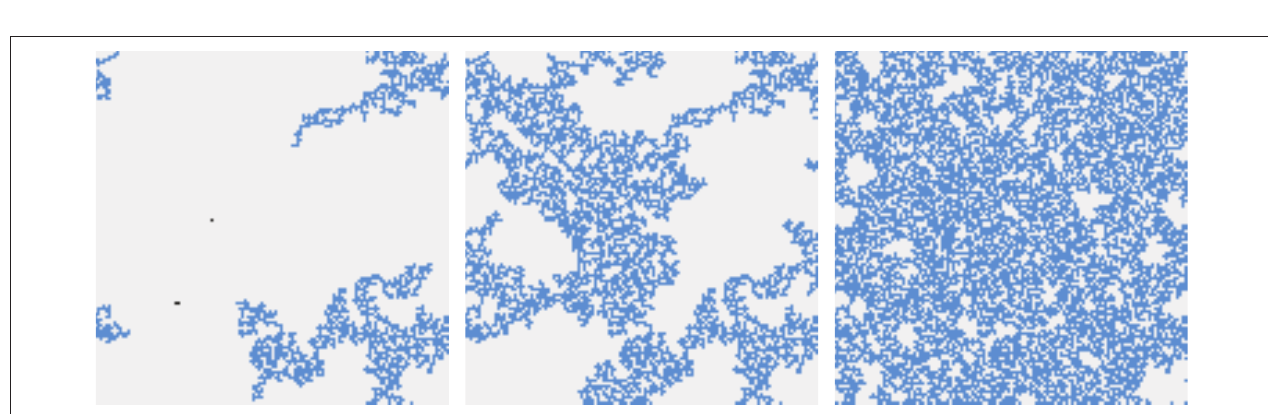
FIGURE 5 | Hole structure of a square lattice ( N = 128 2 ) LLS fiber bundle with the Weibull threshold distribution P ( x ) = 1 − exp ( − x + 1 ) at three different damages: k / N = 0.1 (left), k / N = 0.3 (middle), and k / N = 0.59 (right). Intact fibers are light gray, the largest hole is blue, and other broken fibers are black. From early on in the breaking process a single hole is growing continually.